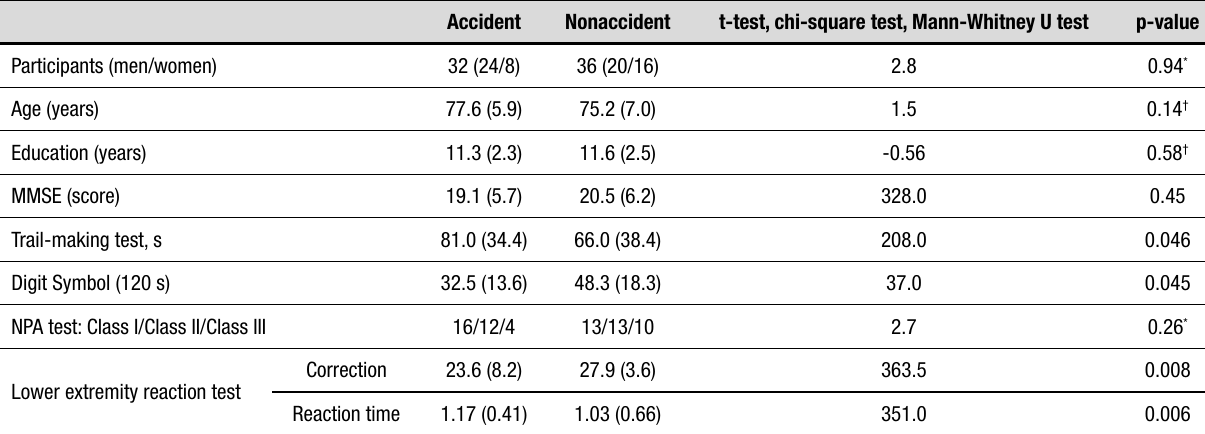
Table 1. Demographics and differences between accident and nonaccident